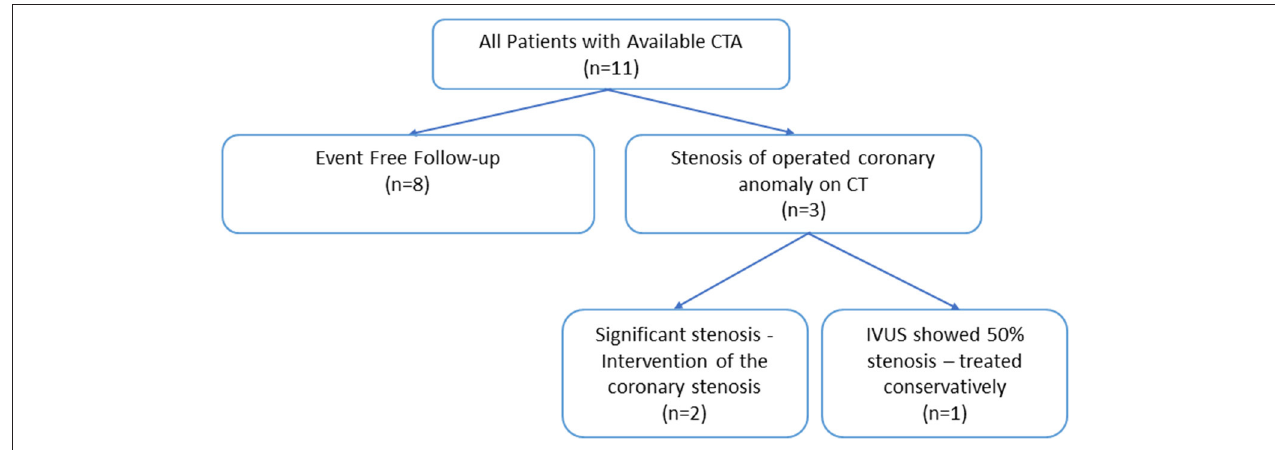
FIGURE 5 | Schematic overview of the study cohort and the outcomes. CTA, computed tomography angiography; IVUS, intravascular ultrasound.